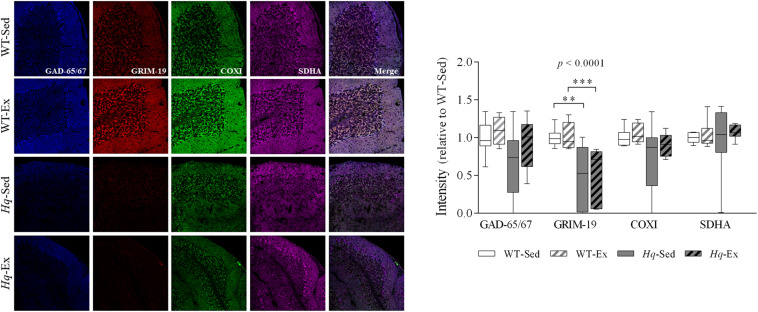
Immunohistochemistry analysis of respiratory complexes and Purkinje neuron markers. Immunodetection of markers of Purkinje cells, GAD-65/67 (blue); respiratory chain complex I, GRIM-19 (red); complex IV, COXI (green); complex II, SDHA (violet); and merged images in slices of cerebellum of wild-type sedentary (WT-Sed, n = 10) and exercise-trained (WT-Ex, n = 9) mice, and Hq sedentary (Hq-Sed, n = 10), and exercise-trained (Hq-Ex, n = 8) mice. Quantitative analysis of the signal intensities: data (median, interquartile range, and min and max values) are expressed relative to the intensity of the WT-Sed group. Significant p-values for group effect (Kruskal-Wallis test) are shown above the corresponding boxes. Symbols for significant differences in post hoc pairwise comparisons: ∗∗p < 0.01; ∗∗∗p < 0.001 for Hq-Sed vs WT-Sed, and Hq-Ex vs. WT-Ex. Abbreviations: COXI, cytochrome c oxidase subunit I; GAD-65/67, glutamate descarboxilase 65/67; GRIM-19, gene associated with retinoic and interferon-induced mortality 19 protein; SDHA, succinate dehydrogenase complex iron sulfur subunit A. Analyses were performed in 1,000 cells (i.e., 187 cells for 7 WT-Sed animals; 168 cells for 5 WT-Ex animals; 293 cells for 6 Hq-Sed 6 animals, and 352 cells for 5 Hq-Ex animals).